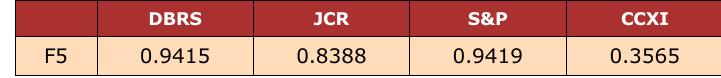
Table 15. The Normalized Data of Four Companies